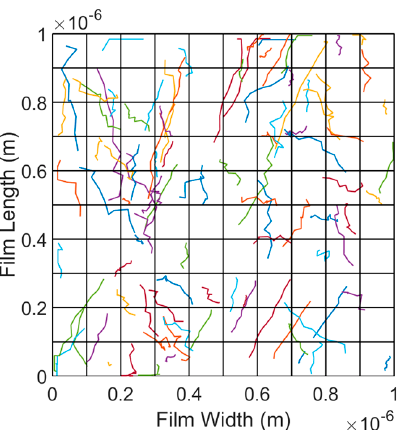
Figure 13. Embedded fibre method grid mesh with element partitioning.